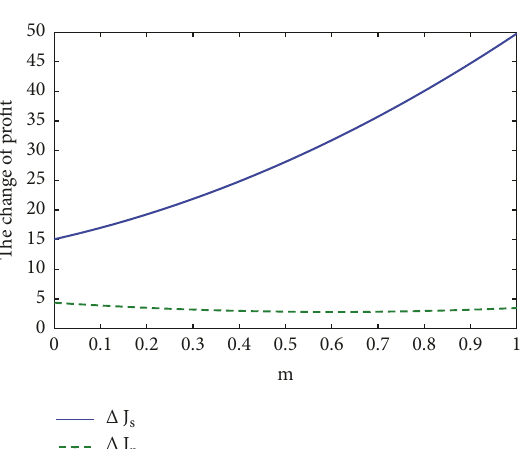
Figure 2: Profit changes.